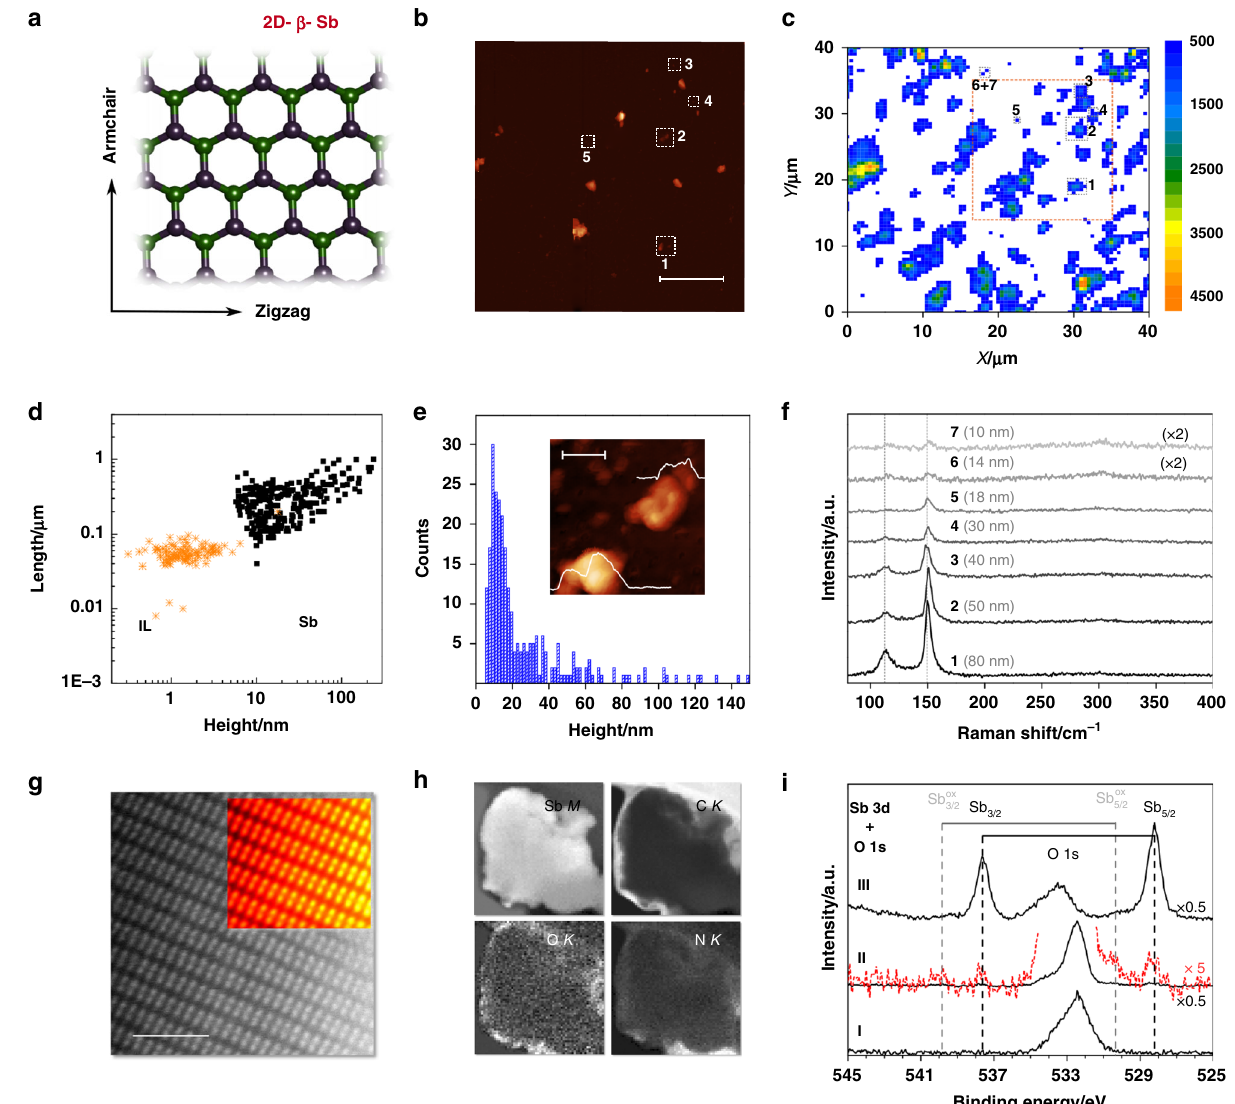
Fig. 2 Characterization of exfoliated antimonene. FL-Sb analysis. a Top view of the rhombohedral structure (R3m space group) of Sb. Upper plane atoms marked in green, lower plane in purple. b Representative AFM topography image (inset, scale bar 5 µ m) of the exfoliated sample spin-coated onto SiO 2 /Si substrates. c The corresponding Raman A 1 g ( λ exc = 532 nm) mapping of the same Sb fl akes (>14,000 single point spectra over a surface area of 40 µ m 2 using a step size of 0.5 µ m). The numbers denote the areas in which the Raman spectra shown in ( f ) were recorded. d Plot of the nanosheet length as a function of the fl ake height (obtained from AFM), including the data corresponding to the IL blank (Supplementary Figures 8 and 9) considering a total amount of 271 and 116 replicates, respectively. e Histogram of the apparent thickness of the exfoliated FL-Sb obtained from AFM (sample size = 271). The inset shows an AFM image of a nanosheet along with its corresponding height pro fi les of ca . 4 and 18 nm, respectively (inset, scale bar 100 nm). f Raman spectra of the nanosheets indicated in b and c (the numbers labeling the spectra in f correspond to the nanosheets marked by numbers in b and c ). g Atomic resolution HAADF image acquired on the edge of a free-standing portion of a fl ake, near the edge, along with a Fourier fi ltered (FFT) image in the inset, acquired down the [210] orientation. The scale bar is 2 nm. h Compositional maps, derived from EEL spectrum images of the fl ake (from the area highlighted with a green rectangle in Supplementary Figure 21). Sb M 4,5 , C K , O K , and N K maps corresponding to this area are shown. Data acquired at 80 kV. i XPS Sb 3 d and O 1 s region of the neat bmim-BF 4 IL (I) showing oxygen signals from an IL related surface contamination layer, of the highly concentrated FL-Sb suspension (II) showing small signals of nonoxidized (Sb 3 d 5/2 at 528.2 eV) and minor contributions from oxidized (530.3 eV) antimony next to the oxygen contamination, and after removal of most of the IL by heating in UHV (III); spectra are offset and rescaled for sake of clarity. Source data are provided as a Source Data fi